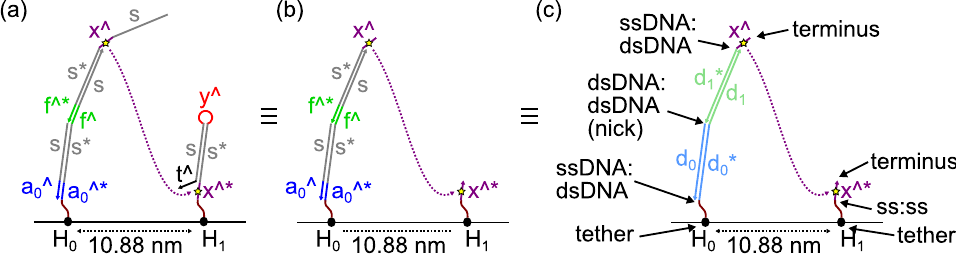
stars indicated the reactive points defined for each structure. ( a ) The hairpins H 0 and H 1 , with input and